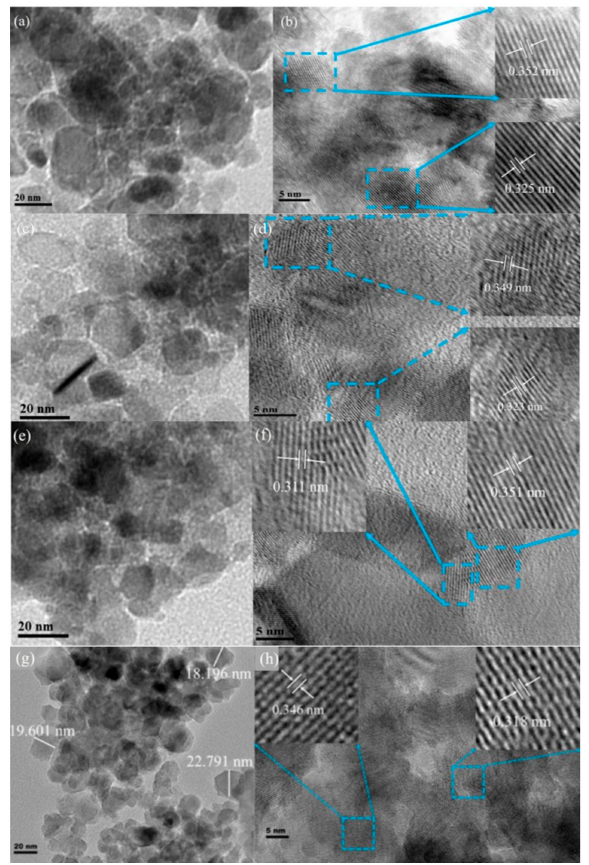
Figure 2. TEM ( a , c , e , g ) and HRTEM ( b , d , f , h ) images of the TiO 2 , V–TiO 2 , Co–TiO 2 , and (V,Co)–TiO 2 samples.